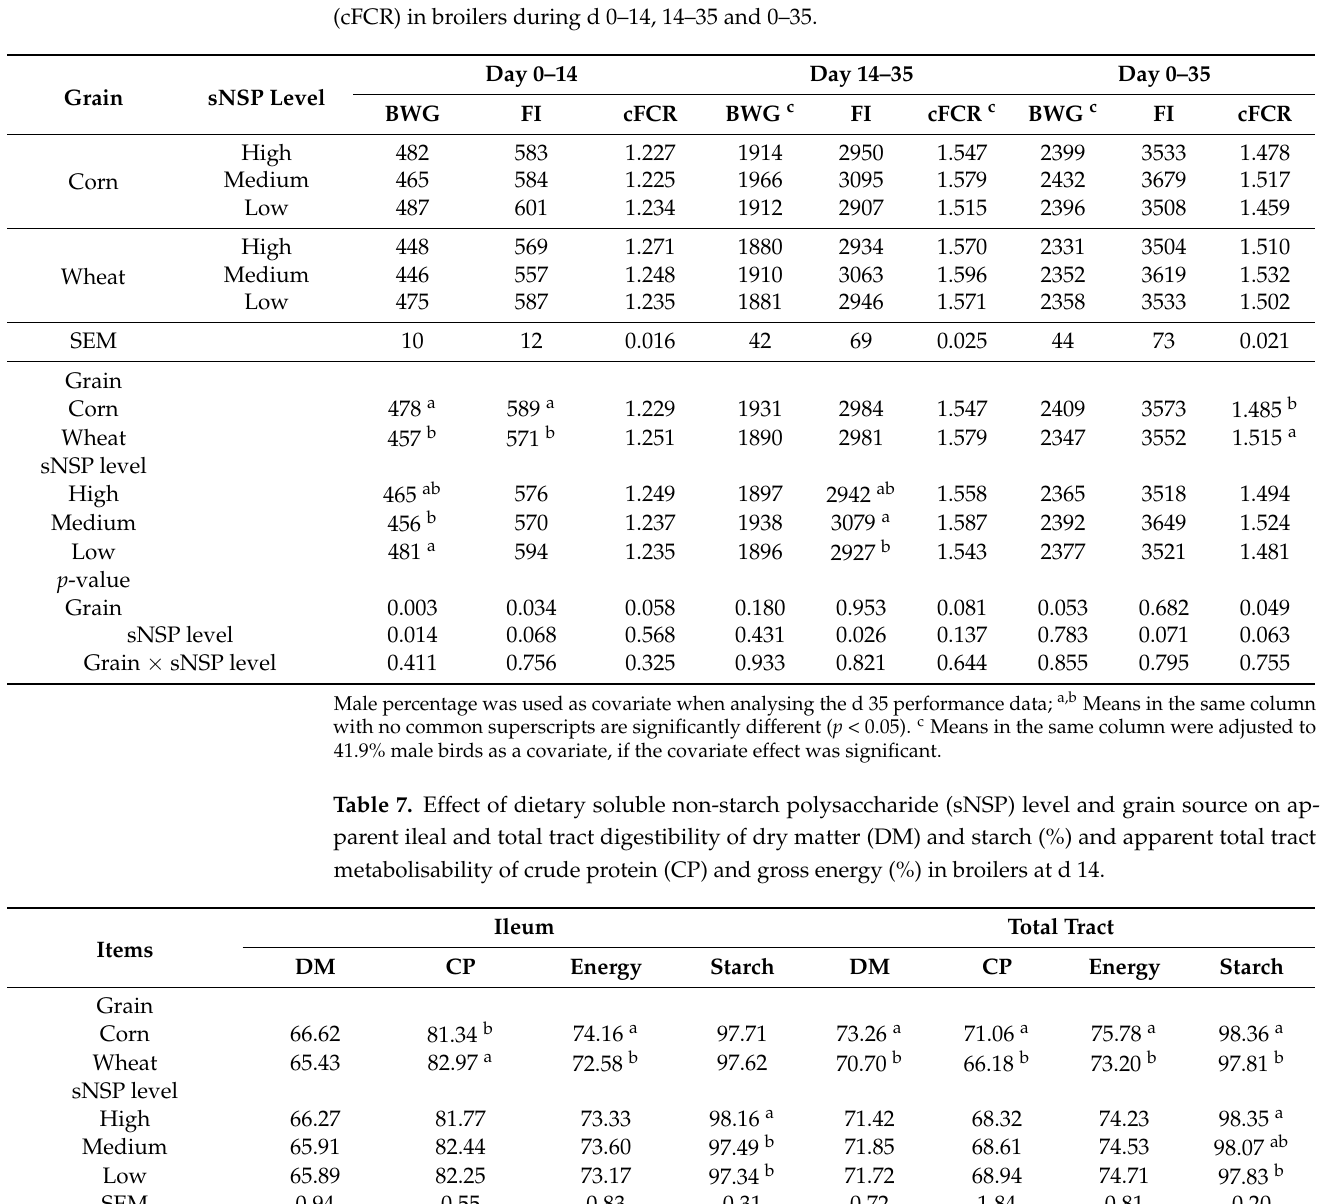
Table 6. Effect of dietary soluble non-starch polysaccharide (sNSP) level and grain source on body weight gain (BWG, g/bird), feed intake (FI, g/bird), and feed conversion ratio corrected to mortality (cFCR) in broilers during d 0–14, 14–35 and 0–35.